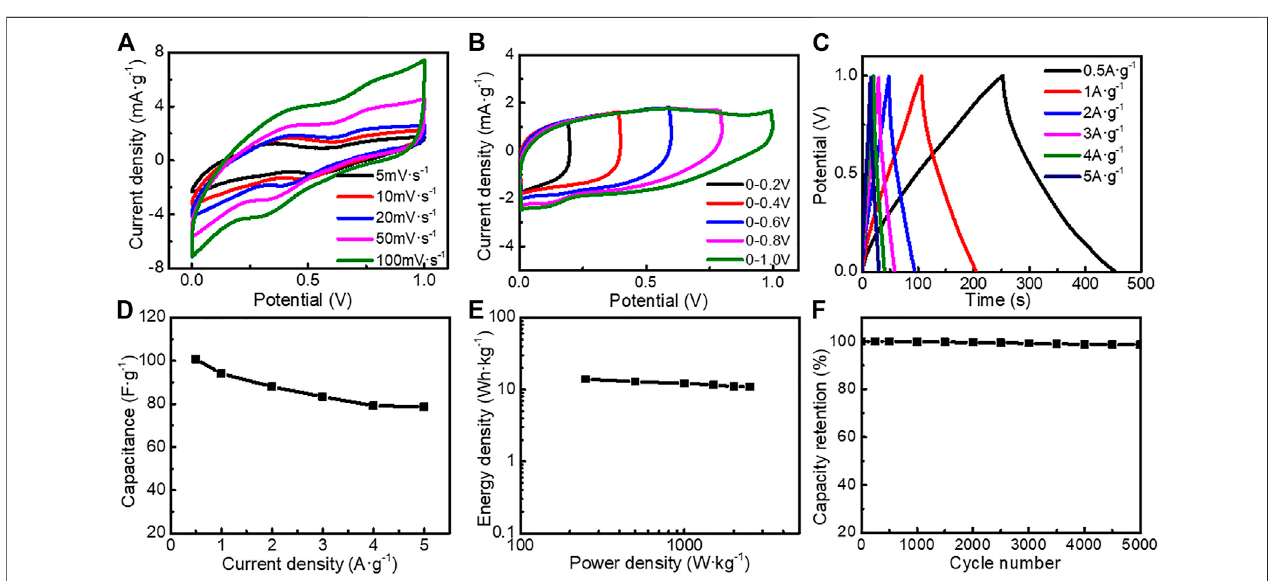
FIGURE 9 | Electrochemical performance of the asymmetric supercapacitor tested in 6 M KOH electrolyte (A) CV curves at different scan rates (B) CV curves at differentpotentialranges (C) GCDcurvesatdifferentcurrentdensities (D) GCDcurvesatdifferentpotentialranges (E) Ragoneplotsoftheasymmetricsupercapacitor (F) cycling stability tested at 5 A g − 1